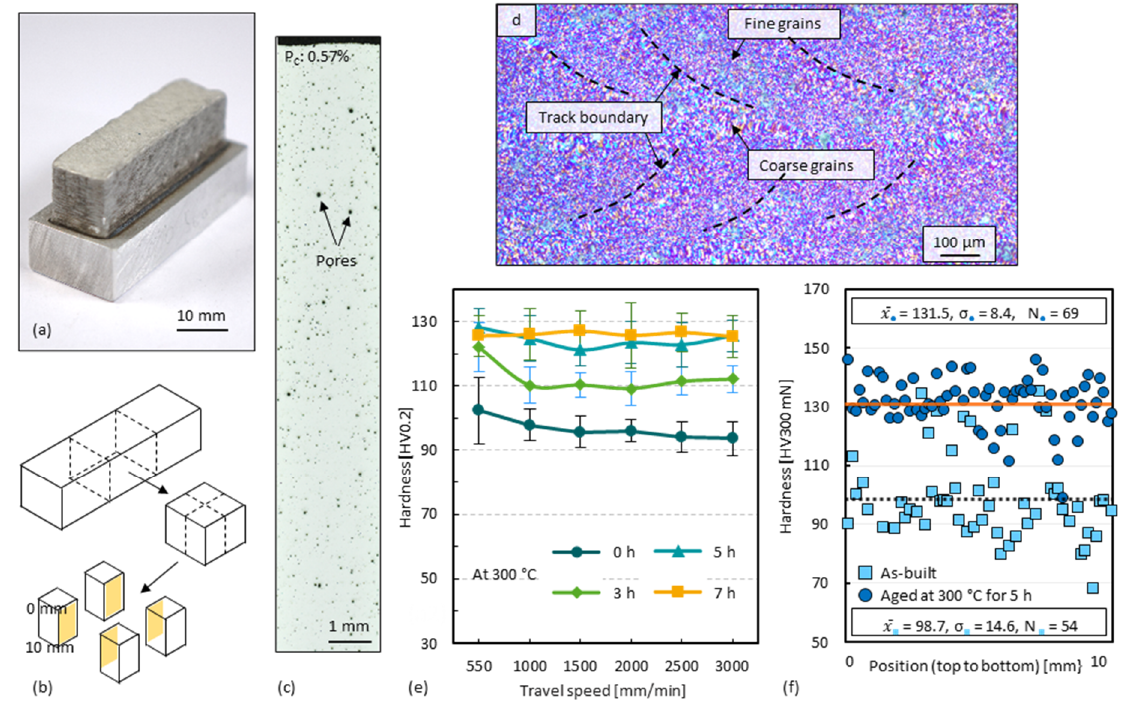
Figure A2. Specimens made of the same material by conventional DED [41], as mentioned in Figure 18 (laser power P = 620 W, travel speed v = 550~3000 mm/min, powder feed rate ṁ = 0.18 g/min, shielding gas flow rate 9 l/min, conveying gas flow rate 5 l/min, laser spot diameter = 1.3 mm, nozzle distance = 7 mm, substrate temperature 18 °C): ( a ) Exterior view of a specimen; ( b ) Sampling position for metallographic analyses; ( c ) cross-section of the specimen and measured cross-sectional porosity P C of 0.57%; ( d ) Barker-etched cross-section; ( e ) Average micro hardness values of samples in different aging states (30 indentations from the top to the bottom of each sample; error bars indicate one standard deviation); ( f ) Values of hardness tests using much lower loads from the top to the bottom (abnormal hardness values less than 0.8 and more than 1.2 times of the mean value of the hardness of five adjacent indentations were filtered out as the indentations on pores. x : average hardness value; σ : standard deviation; N: number of data points; dashed line: average hardness of as-built specimens; solid line: average hardness of aged specimens).